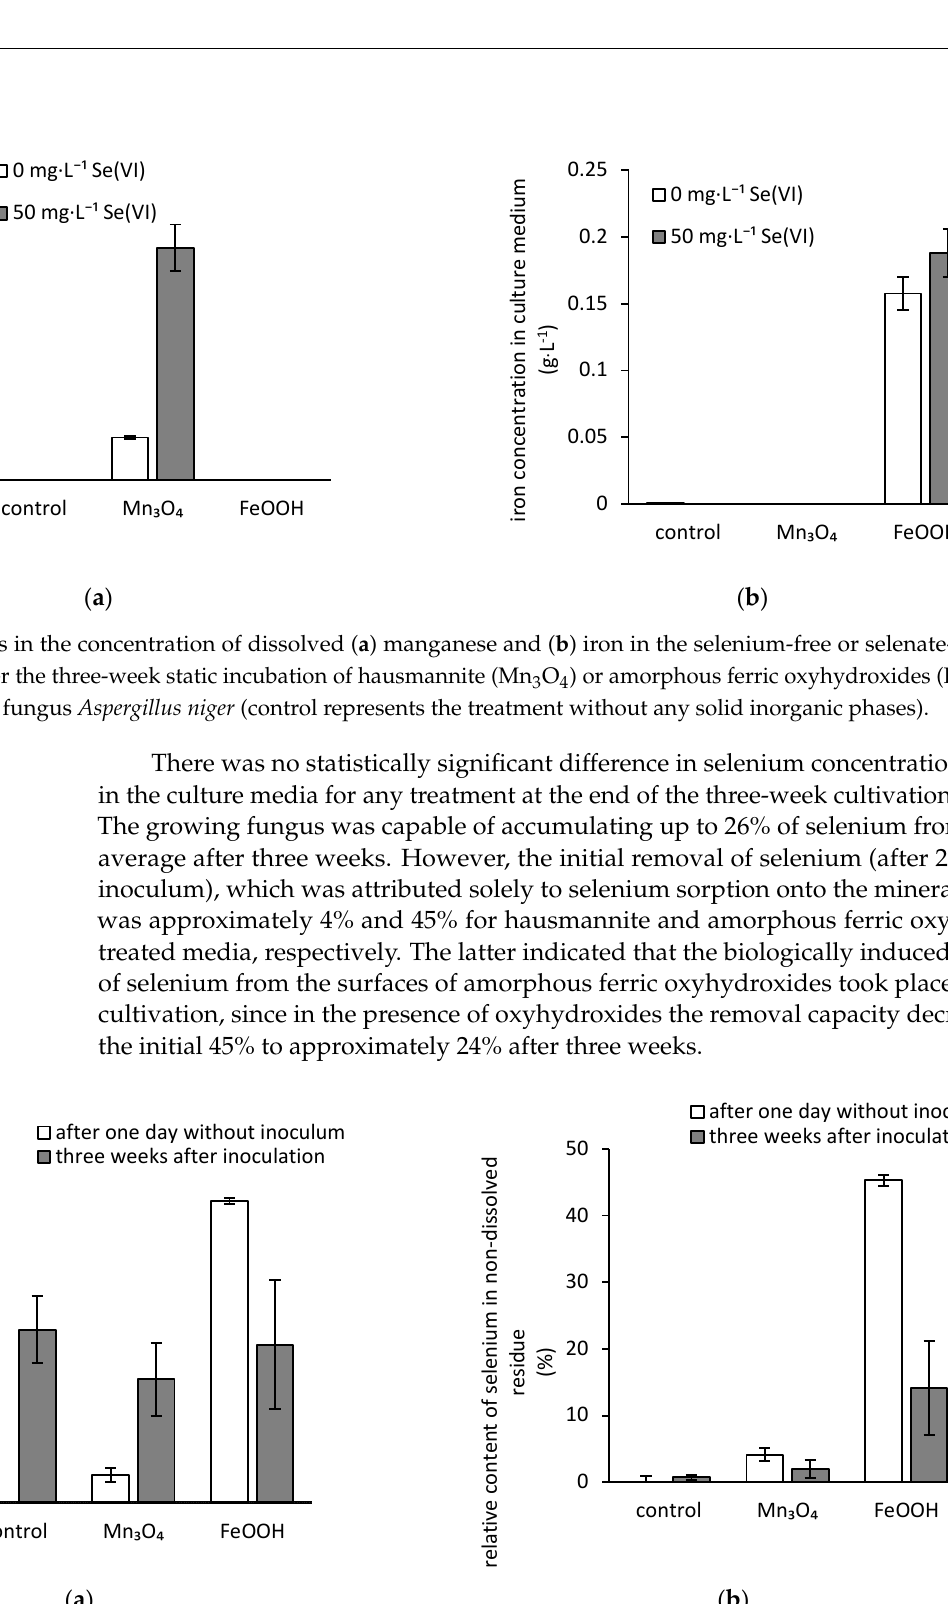
Figure 3. Relative changes of selenium concentrations in ( a ) culture media and ( b ) residual ferric and manganese non- dissolved residues before inoculation and after the three-week static incubation of hausmannite (Mn 3 O 4 ) or amorphous ferric oxyhydroxides (FeOOH) in the presence of fungus Aspergillus niger and selenium, which was introduced into the medium in the form of selenate (control represents the treatment without any solid inorganic phases; initial concentration of total selenium in culture medium was 50 mg ⋅ L − 1 ).